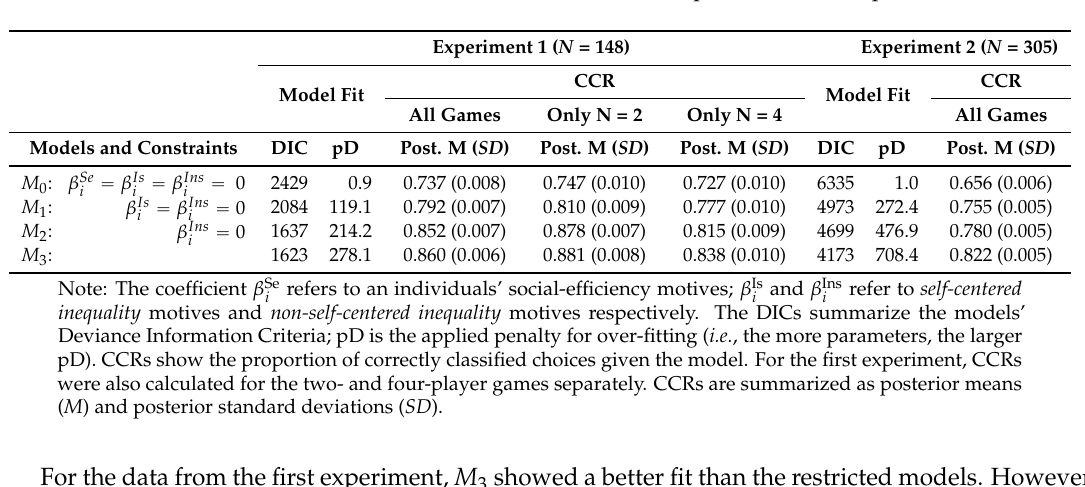
Table 6. Model fit and correct classification rates (CCR) in experiment 1 and experiment